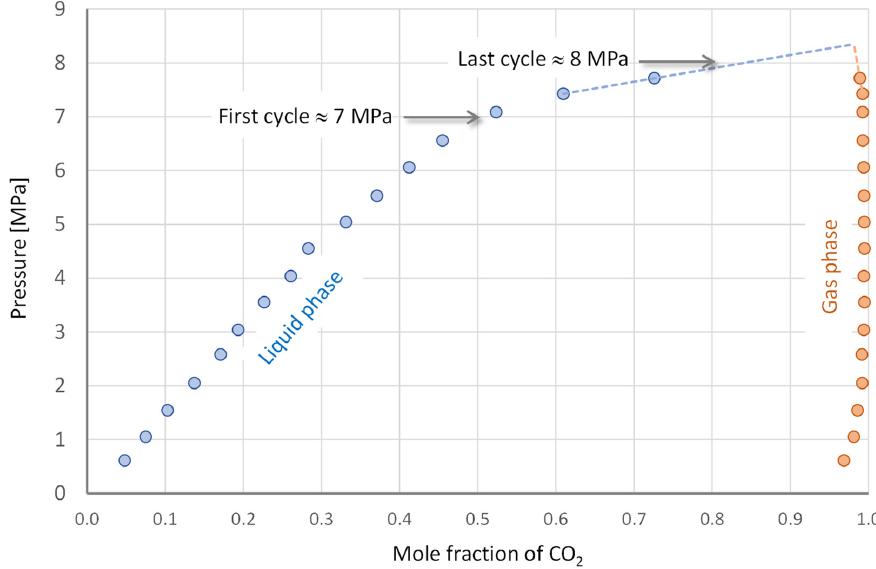
Figure 10. Published experimental data of CO 2 + ethanol phase equilibrium at 40 °C [30], and pressures measured during multi-cycle impregnation tests.